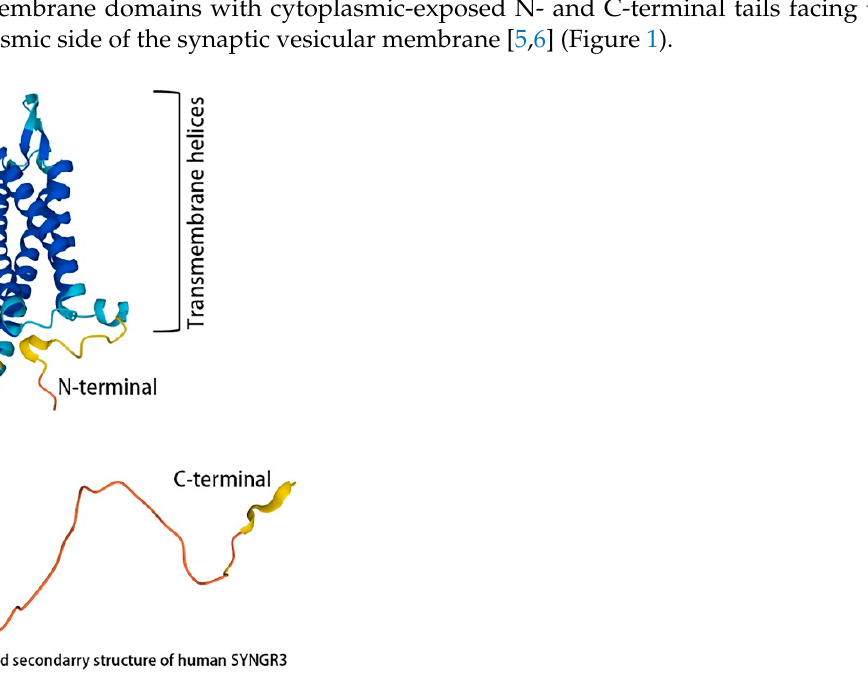
Figure 1. Predicted structure of the human SYNGR3 protein revealed free hanging N- and C-terminal in the cytosol (image source from Uniprot—a freely accessible database of protein sequence and functional information, with modifications ).